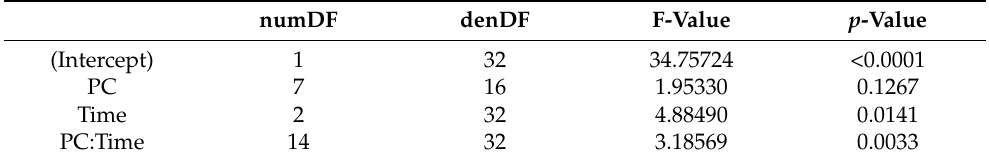
Table 3. Repeated-Measures ANOVA to test whether there are significant differences in clothianidin (0.15 ppb) degradation by the seven probiotic candidates (PC) over time (significant p -values < 0.05). numDF denDF F-Value p -Value (Intercept) 1 32 34.75724 PC 7 1.95330 0.1267 Time 2 PC:Time 14